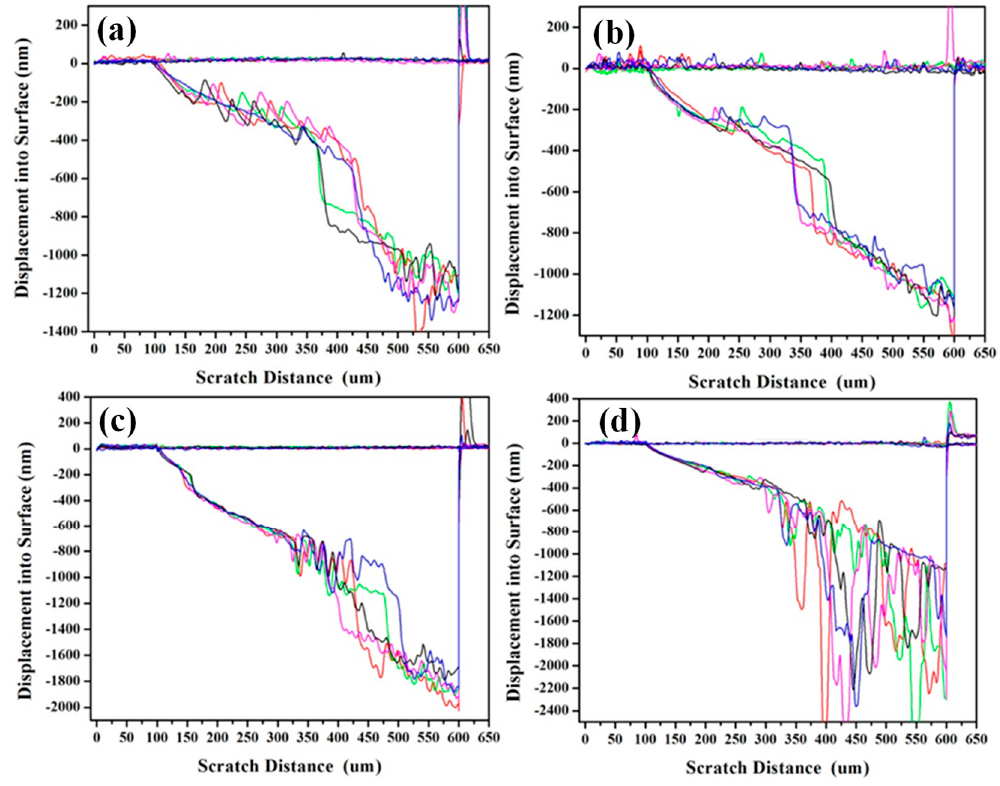
Figure 7. (Color online) The relationship between displacement into surface and scratch distance recorded during the scratch experiments performed for the ( a ) Mo-1, ( b ) Mo-2, ( c ) Mo-4, and ( d ) Mo-8 samples.